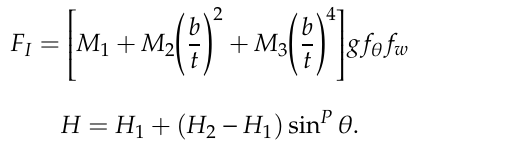
The parameter E ( k ) in Formula (8) and the parameters in Formulas (11) and (12) are given